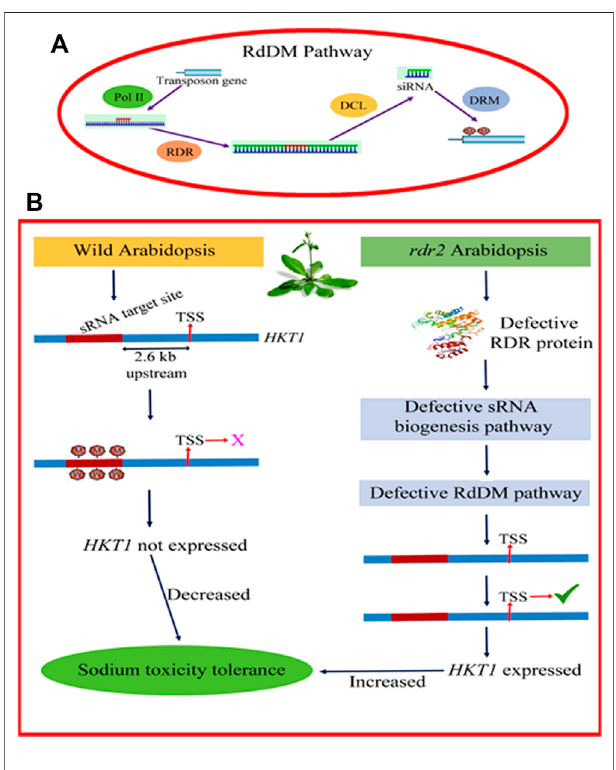
FIGURE2|(A) RDR-dependentRdDMpathway.Thispathwayprovides a means to establish RNA – directed DNA methylation (RdDM) and eventually ensurestable transcriptionalgenesilencing(TGS) (B) RoleofRDR-dependent RdDM pathway in regulating the methylation landscape of HKT1 gene in